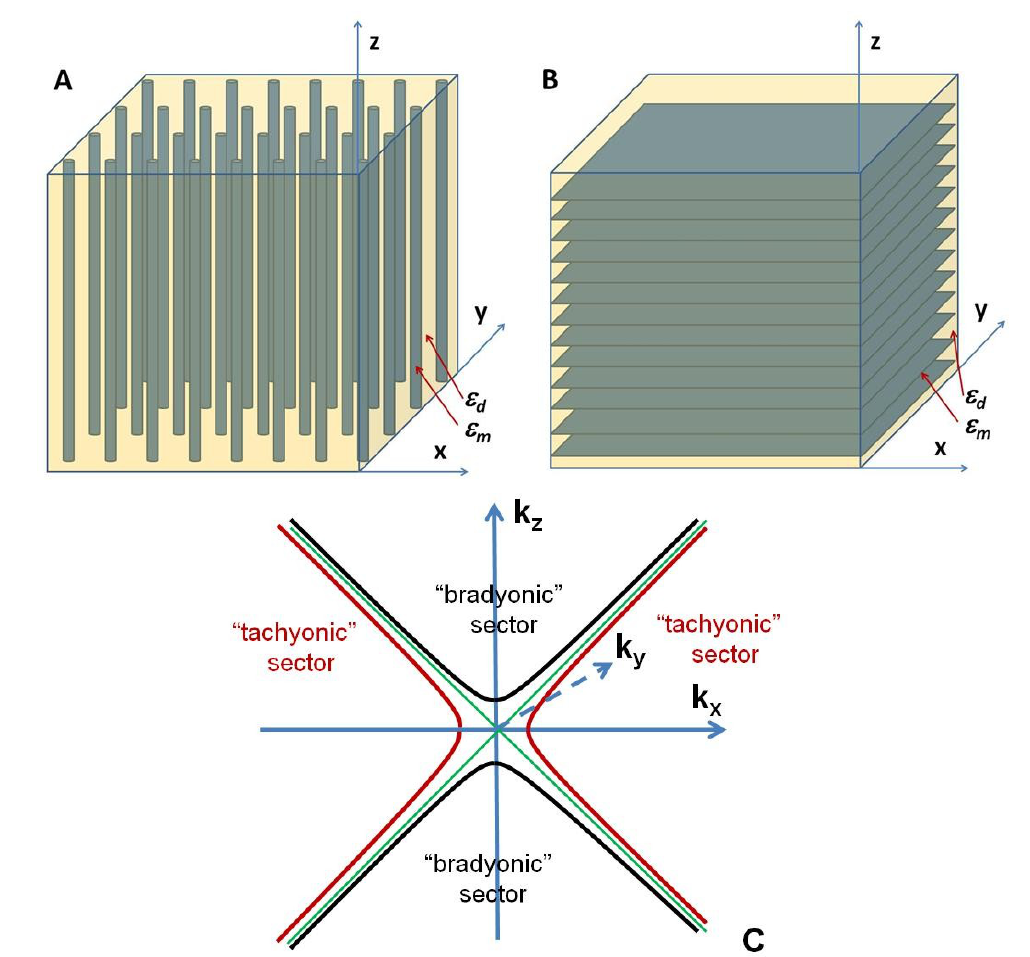
Figure 1. Typical geometries of hyperbolic metamaterials: ( a ) metal wire array structure, and ( b ) multilayer metal-dielectric structure. The role of time in the effective 3D Minkowski spacetime is played by z coordinate aligned with the optical axis of the metamaterial, while k behaves as an effective “energy”; depending on frequency range and z materials used, both configurations may exhibit either bradyonic or tachyonic dispersion relations shown in ( c